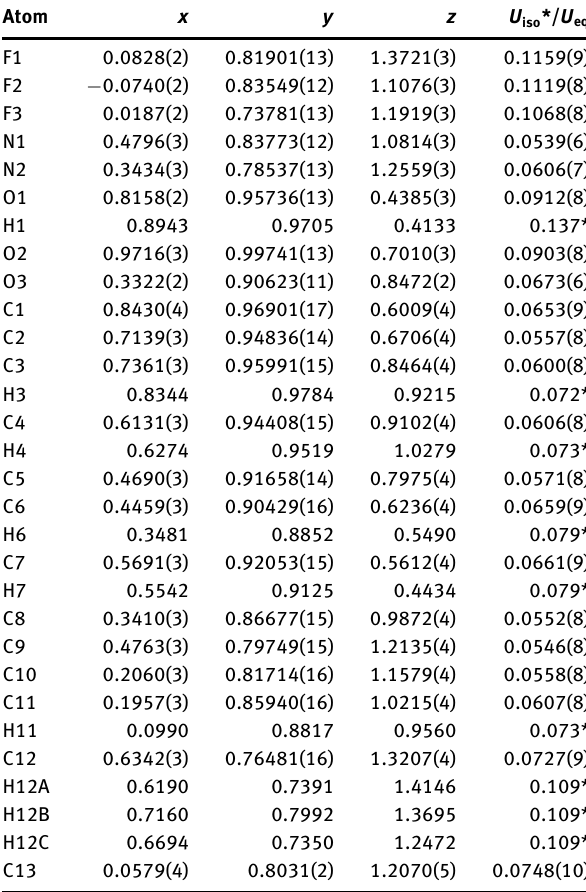
Table 2: Fractional atomic coordinates and isotropic or equivalent isotropic displacement parameters (Å 2